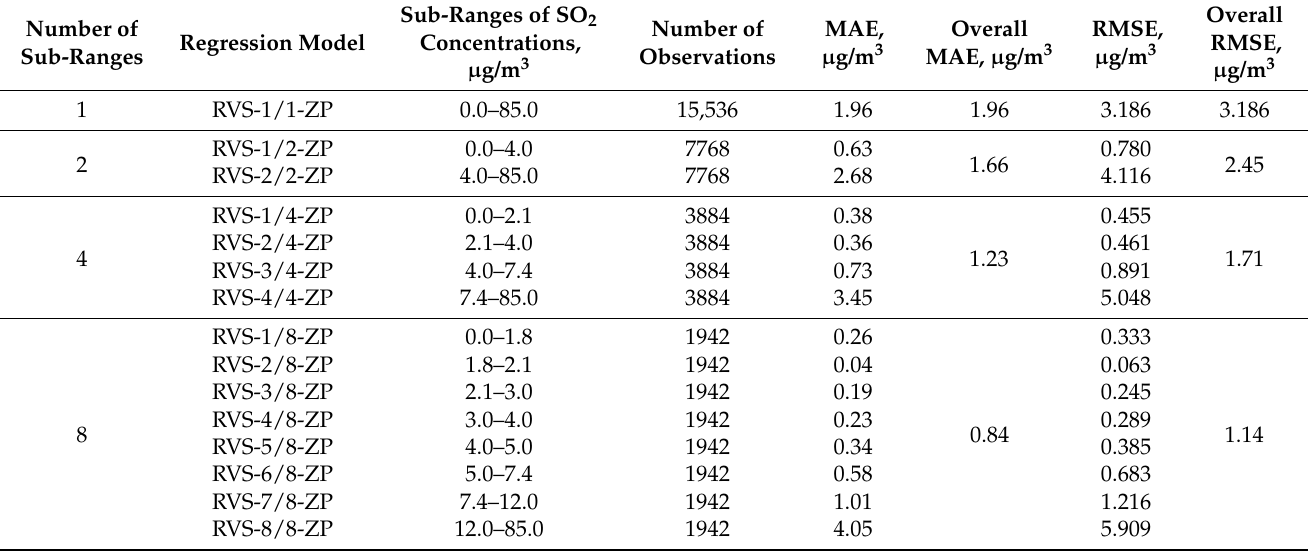
Table 18. Values of approximation errors of SO 2 concentrations in RVS models, Złoty Potok